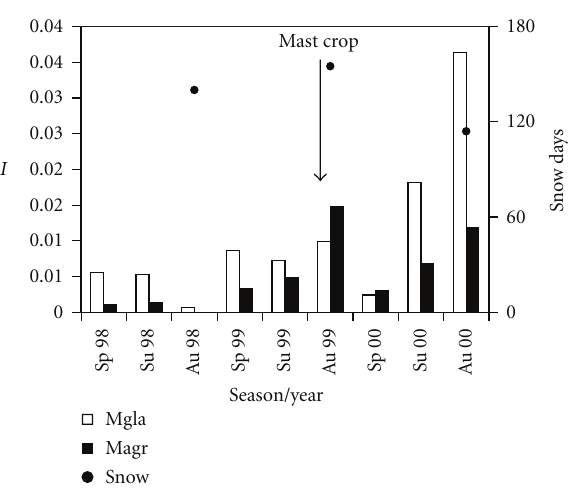
Figure 2: Influence of various forest types (management) on the rodent damage. Di ff erent letters above the graphs indicate statistical significant di ff erences between habitats ( ∗ P < 0 .